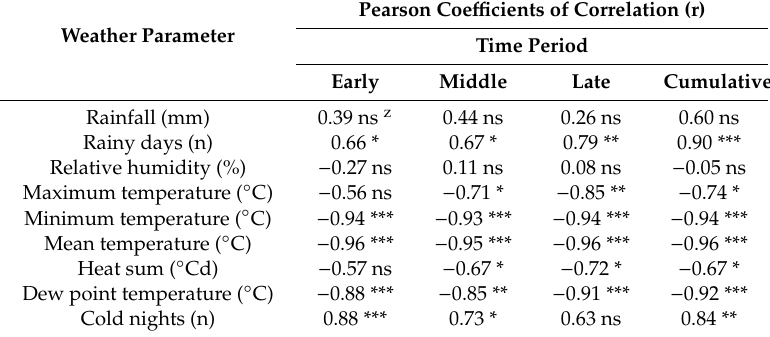
Table 7. Pearson correlation between climatic variables and russeting for ‘Apple’ mango fruits grown at ten sites throughout Kenya. Climatic variables include rainfall amount, number (n) of rainy days, relative humidity, maximum, minimum, and mean daily temperatures, and heat sum. Heat sum is the sum of mean temperatures above the base temperature of 16 ◦ C. Number of cold nights is the sum of the number of days when the minimum temperature was less than 16 ◦ C. The growth season was divided into three periods of equal duration at each site (early, middle, and late phases). “Cumulative” refers to the entire growth period. Climatic data were obtained from the NASA Langley Research Centre (LaRC) POWER Project. Pearson Coe ffi cients of Correlation (r) Weather Parameter